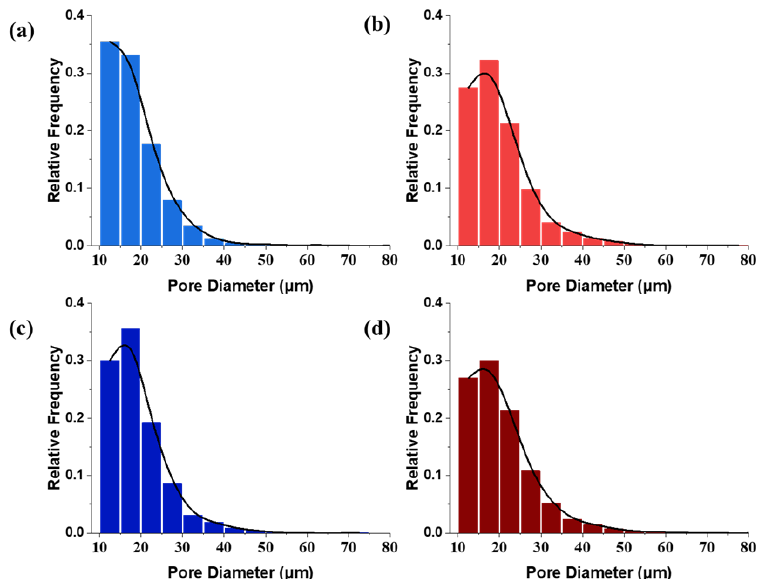
Figure 3. Graphs representing the pore diameters vs. relative frequency for the L-PBF specimens ( a ) H4 ( b ) H12.5 ( c ) V4 and ( d ) V12.5.